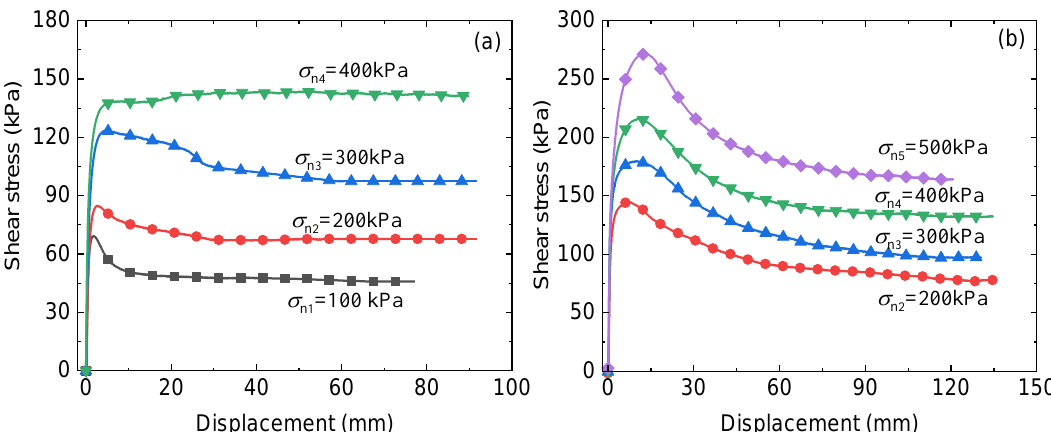
Figure 8. Ring shear test curve of slip zone soil. ( a ) Ring shear test curve of slip zone soil from Huangtupo landslide; ( b ) ring shear test curve of slip zone soil from Shizibao landslide.